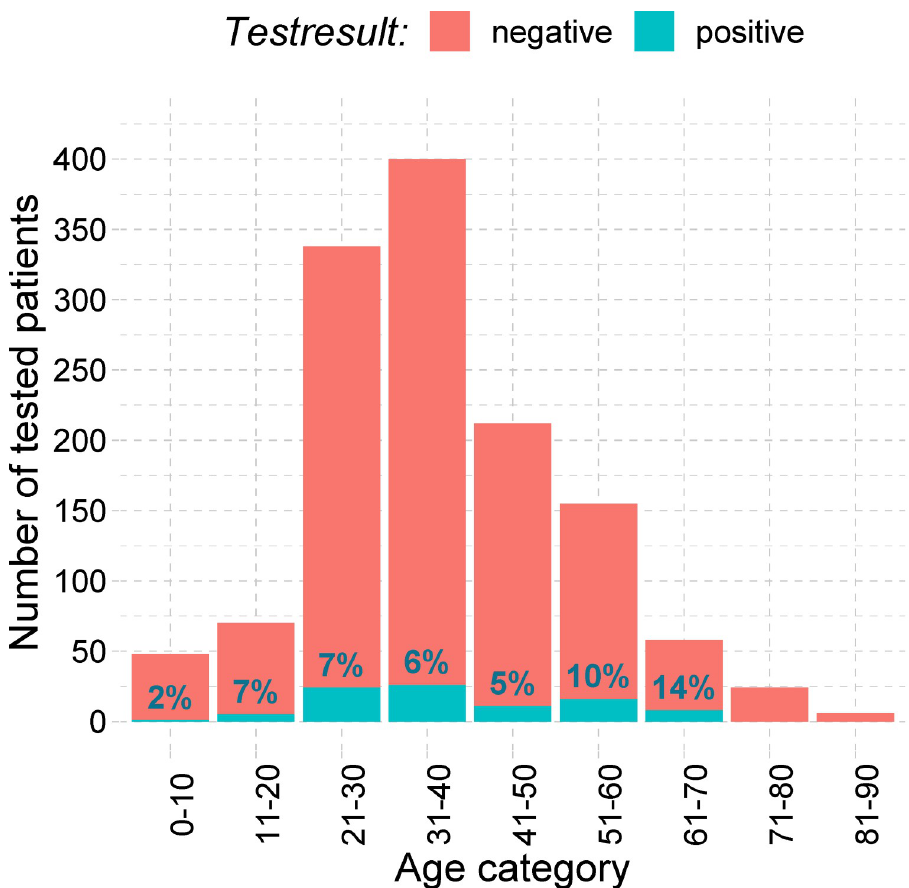
Fig 2. Number of tested patients and observed test-positives per age group (n = 1460).